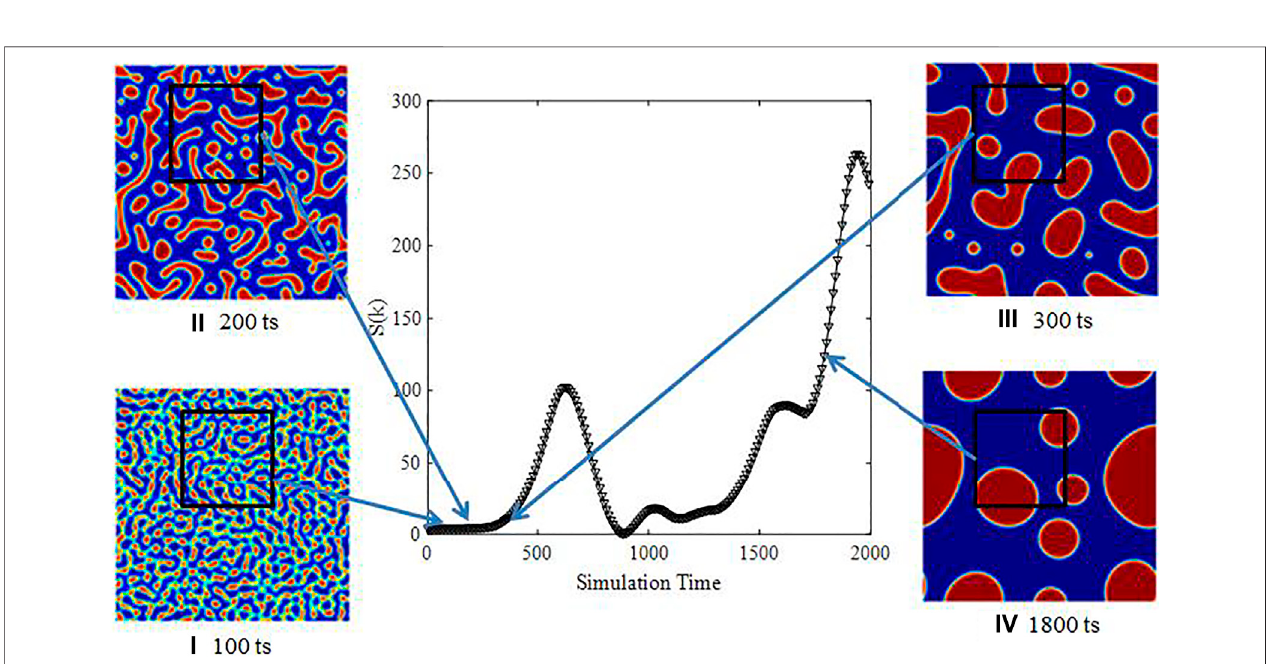
FIGURE6| Temporalevolution of mean structurefactorsover entire domain in thephaseseparation system with interactivestrengthsof G (cid:2) − 30atfour times: (A) 100 ts, (B) 200 ts, (C) 300 ts, and (D) 1800 ts.